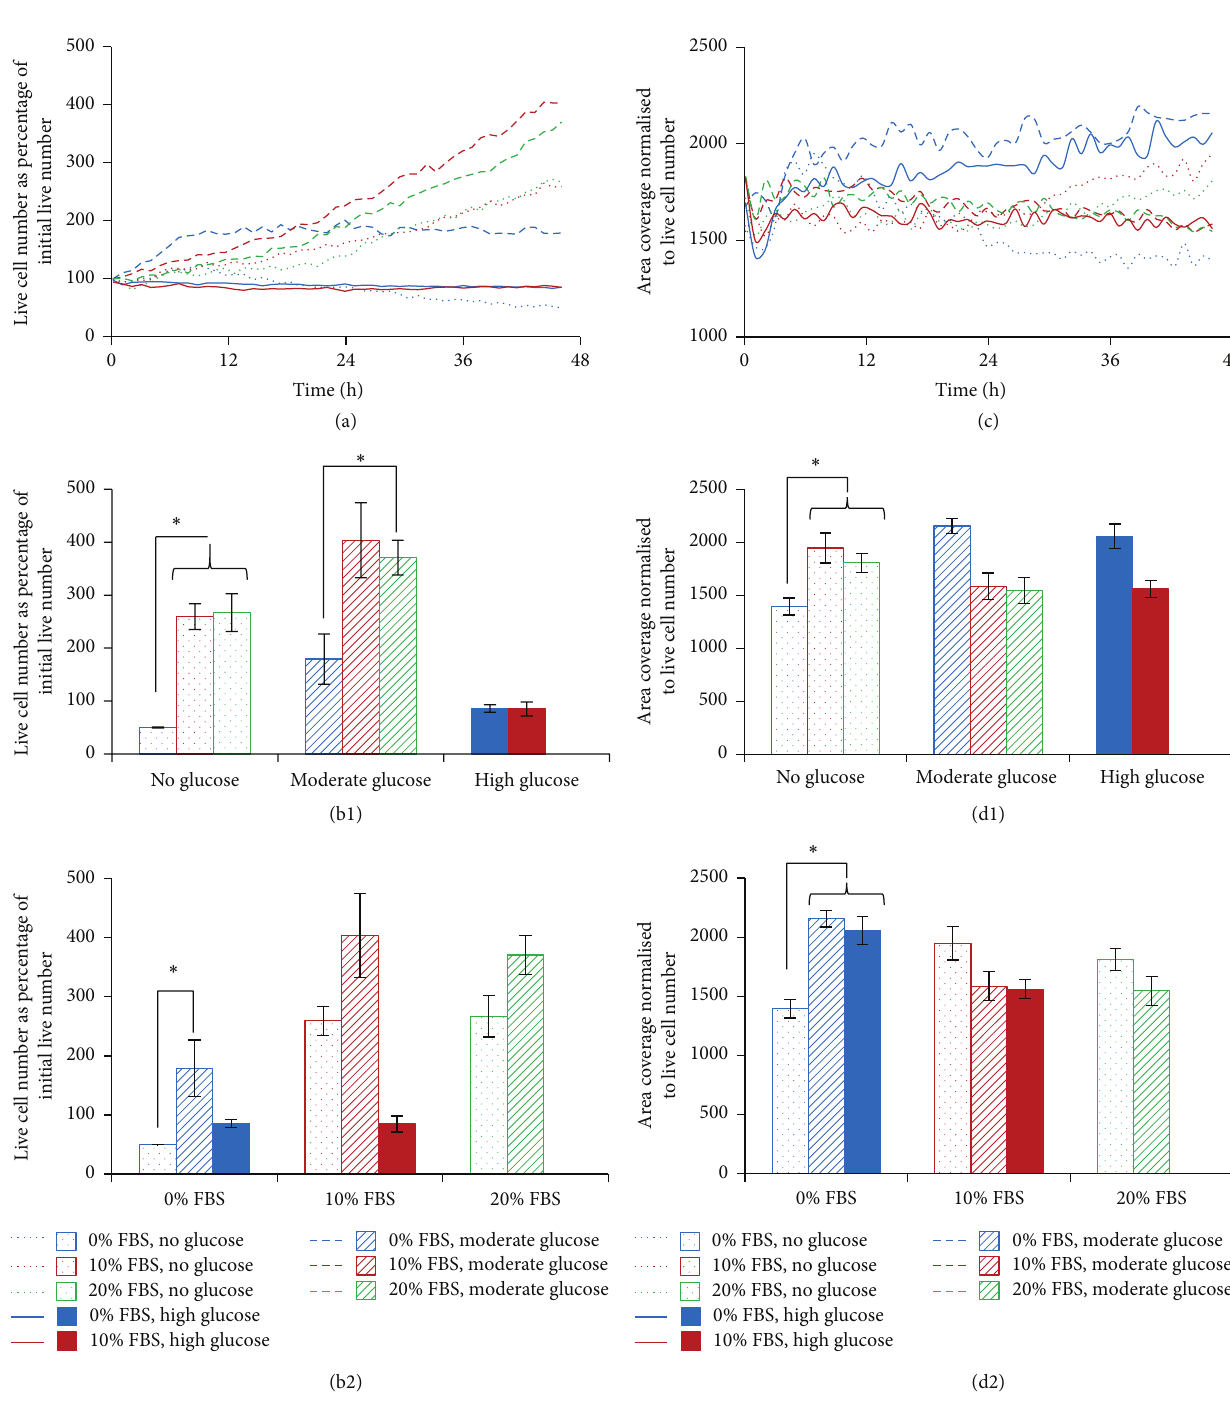
Figure 2: Monitoring the response of bovine NP cell cultures to changes in FBS and glucose concentration over 48 hours. (a) Temporal analysis for live cell number, expressed as the percentage of the initial live cell number. (b) Live cell number, expressed as a percentage of the initial live cell number at the final time point ( ± SEM), comparing FBS levels within glucose subgroup (b1) and comparing glucose levels within FBS subgroup (b2). (c) Temporal analysis for area coverage normalised to live cell number. (d) Cell area, normalised to live cell number, at the final time point ( ± SEM), comparing FBS levels within glucose subgroup (d1) and comparing glucose levels within FBS subgroup (d2). ∗ represents a statistically significant difference of 𝑝 < 0.05